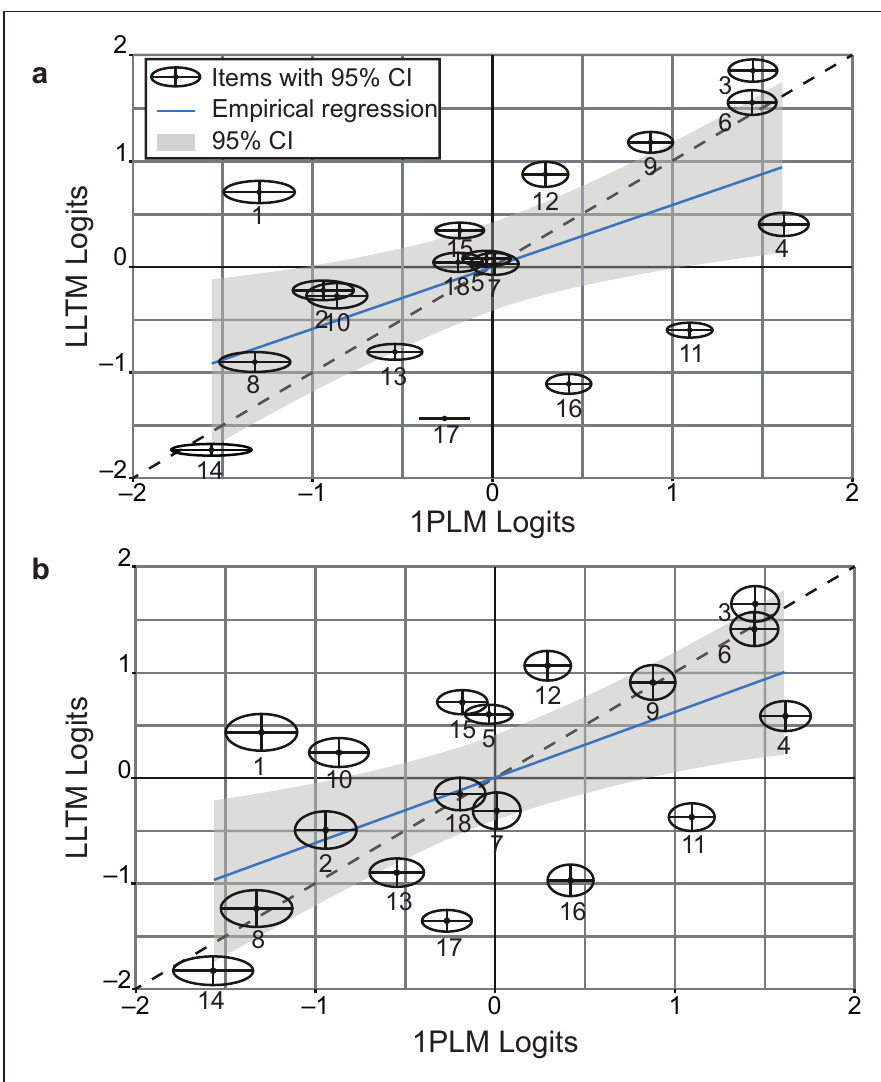
Figure 3 Graphical test of ( a ) the basic model and ( b ) the extended model that compares the item difficulties (logits) for items 1–18 between the descriptive one-parameter logistic model (1PLM) Rasch model (x-axis) and the explanatory linear logistic test model (LLTM) Rasch model (y-axis)